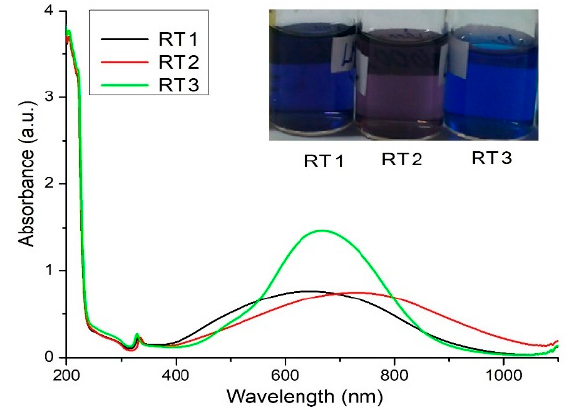
Figure 3. UV-VIS spectra of samples encoded RT .